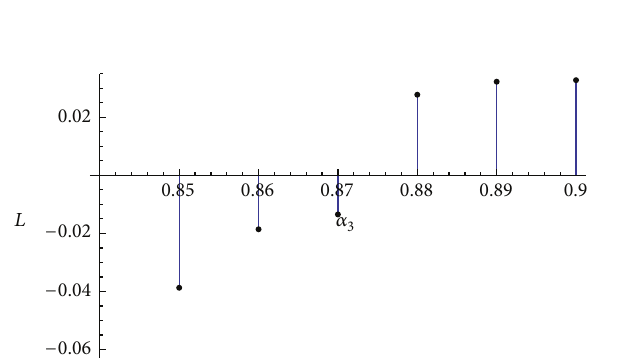
Figure 11: Phase portrait y - z 𝛼 3 = 0.87, 𝛼 2 = 𝛼 1 = 1 .